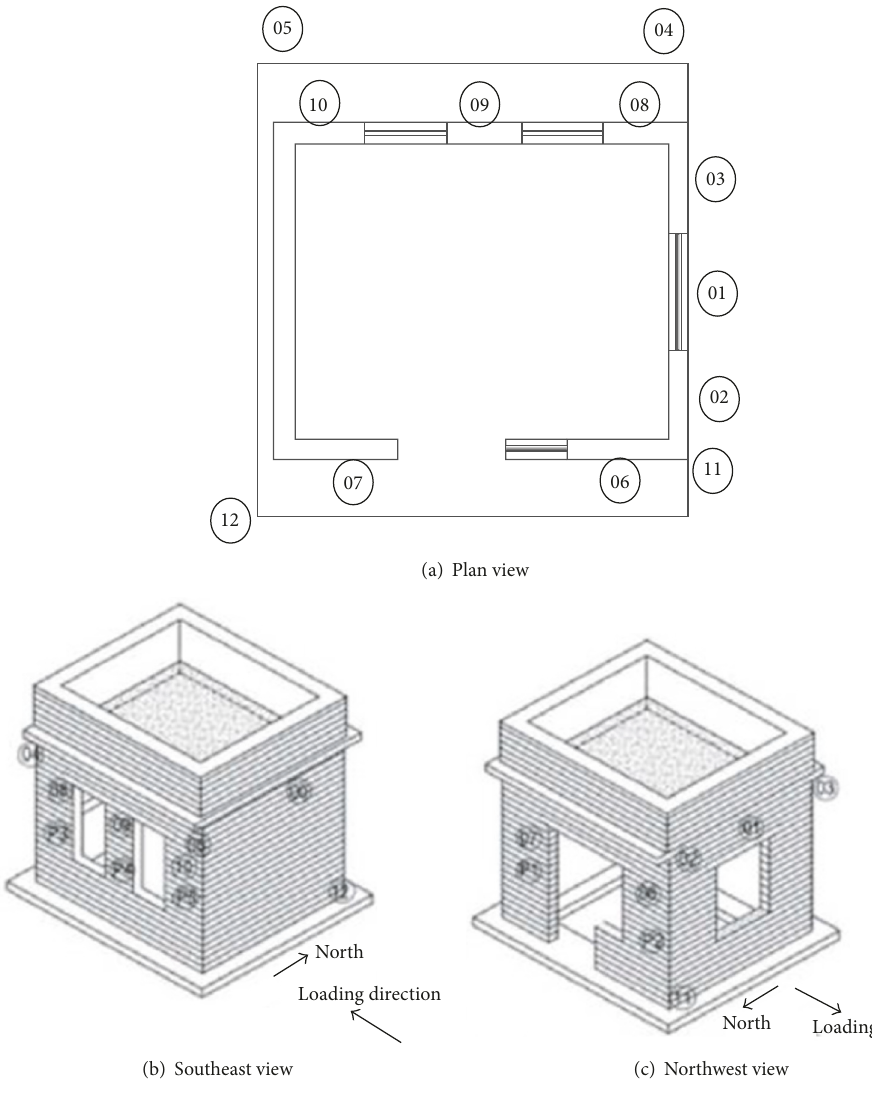
Figure 4: Location of LVDTs on the full-scale building model.